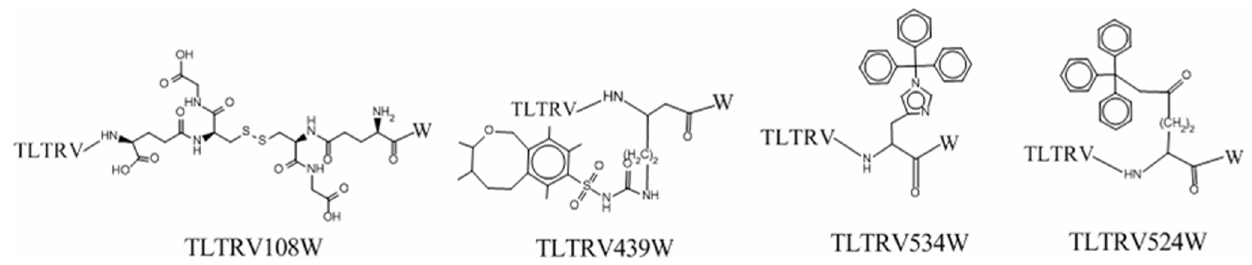
Figure 7. The newly designed mica-binding peptide mimetics. The 13th sample in training set, TLTRVGW, is regarded as a template to design molecules. The predicted score of TLTRVGW, TLTRV108W, TLTRV439W, TLTRV534W and TLTRV524W is 0.94, 1.00, 1.00, and 1.00, respectively.